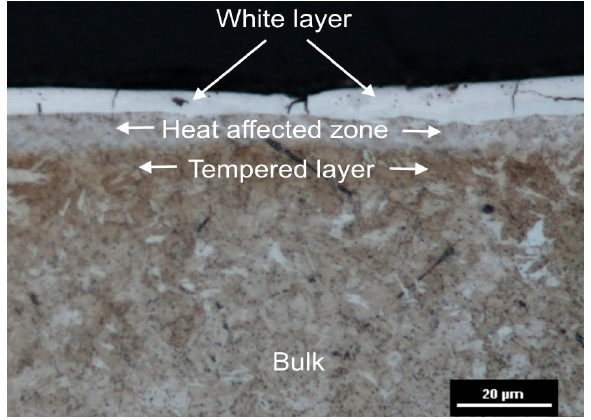
Figure 9. Metallographic structure of HTCS 150 after the EDM process.